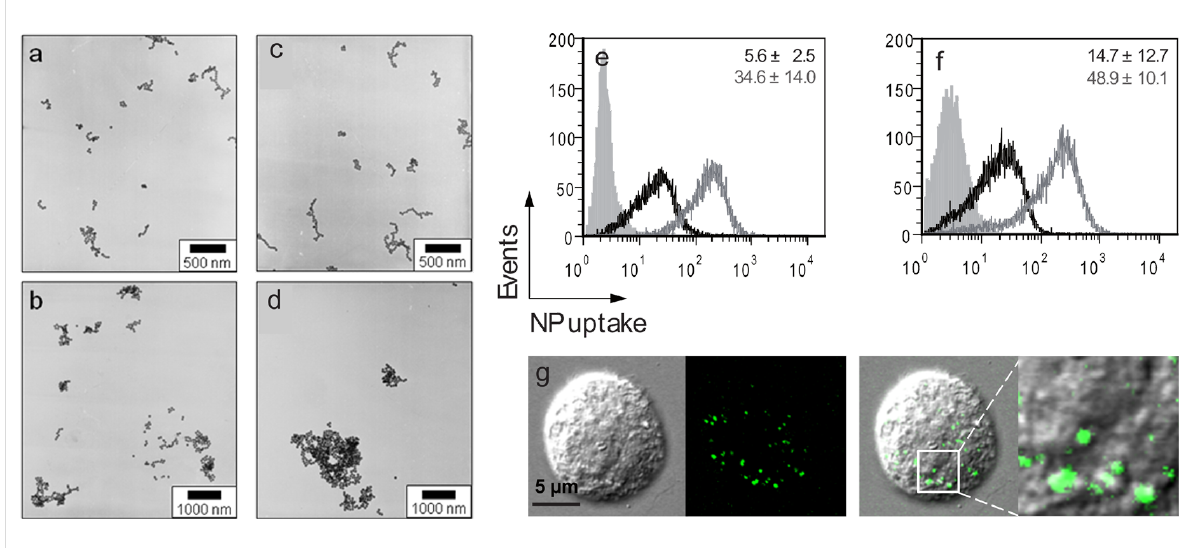
Figure 3: Uptake of fluorescent silica nanoparticles with variable size and surface functionalization by HaCaT cells. Different type of particles were prepared (a–d) with a size of 42 (a,c) or 75 nm (b,d) as well as negative (a,b) or positive (c,d) surface charge through funtionalization with (3-amino- propyl)triethoxysilane (APS) groups. Cells were incubated with particles (10 µg/mL, 2 h, 37 °C) and analyzed by means of flow cytometry (e,f) and confocal laser scanning microscopy (g). Cells incubated with non-functionalized (black lines) and APS-functionalized (grey lines) SiO 2 particles showed a positive, particle-related signal with respect to the untreated control cells (filled silver histograms). CLSM (Olympus FV1000) confirmed the internalization of both particle aggregates and single particles. Inset shows the four fold magnification of the boxed area. (Modified with permission from [3], Copyright 2012 American Chemical